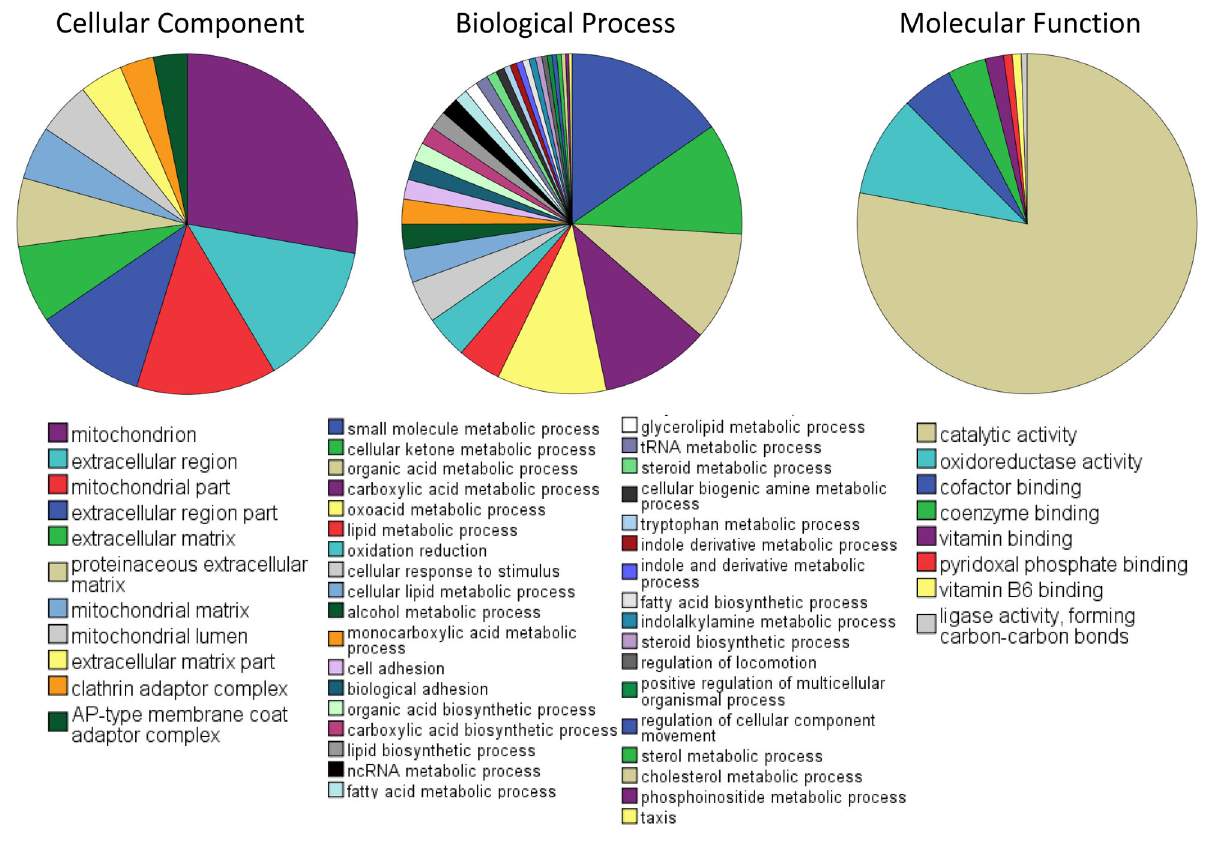
Figure 3. GO terms that are over-represented in the developing eye of the Nautilus versus the developing eye of the squid. Results generated using fisher’s exact test corrected with multiple selection between contigs expressed at least two-fold in the Nautilus sample versus the squid